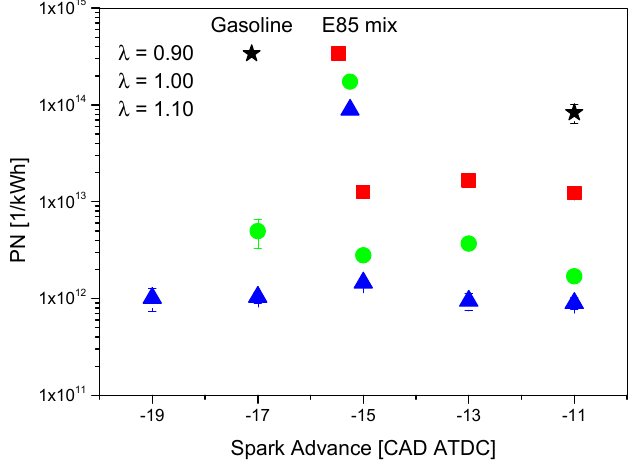
Figure 13. PN as a function of the spark advance for E85 mix.